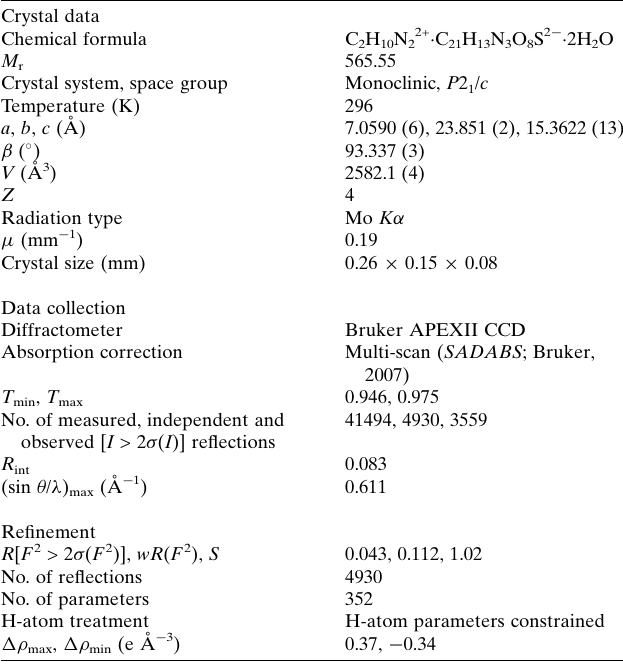
Table 3 Experimental details. Crystal data Chemical